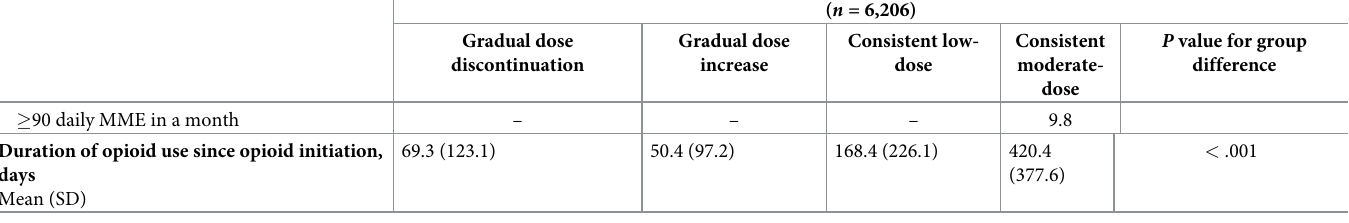
their controls ( S2 Fig ) and among cases with opioid poisoning encounters and their controls ( S3 Fig ). In adjusted multivariable conditional logistic regression analysis, prescription opioid dose trajectories were independently associated with risk for an ORAE encounter ( Table 4 ). Com- pared to patients with gradual dose discontinuation, those with graduate dose increase had a 3.4-fold (95% CI 2.8 to 4.0; P < 0.001), those with consistent low dose had a 3.8-fold (95% CI 3.2 to 4.6; P < 0.001), and those with consistent moderate dose had an 8.5-fold (95% CI 6.8 to 10.7; P < 0.001) increased risk for having an incident ORAE encounter, after adjustment for covariates. Stratification analysis by specific types of opioid encounters showed similar results, with the gradual dose increase, consistent low dose, and consistent moderate dose group hav- ing an increased risk for opioid misuse/dependence or poisoning when compared to the group with decreasing dose trajectory ( S4 Table ). Our main findings remained robust in the sensitivity analysis using a cohort study design. The increased risk of ORAE among patients with the gradual dose increase (adjusted hazard ratio [HR] = 4.4; 95% CI 3.8 to 5.1; P < 0.001), consistent low dose (aHR = 1.9; 95% CI 1.6 to compared to those with the gradual dose discontinuation, persisted in a cohort design ( S7 Table ). Further stratification by the duration of follow-up revealed a higher risk of ORAE in the earlier months (i.e., first or second month) of the follow-up defined in the cohort design as a sensitivity analysis ( S7 Table ).